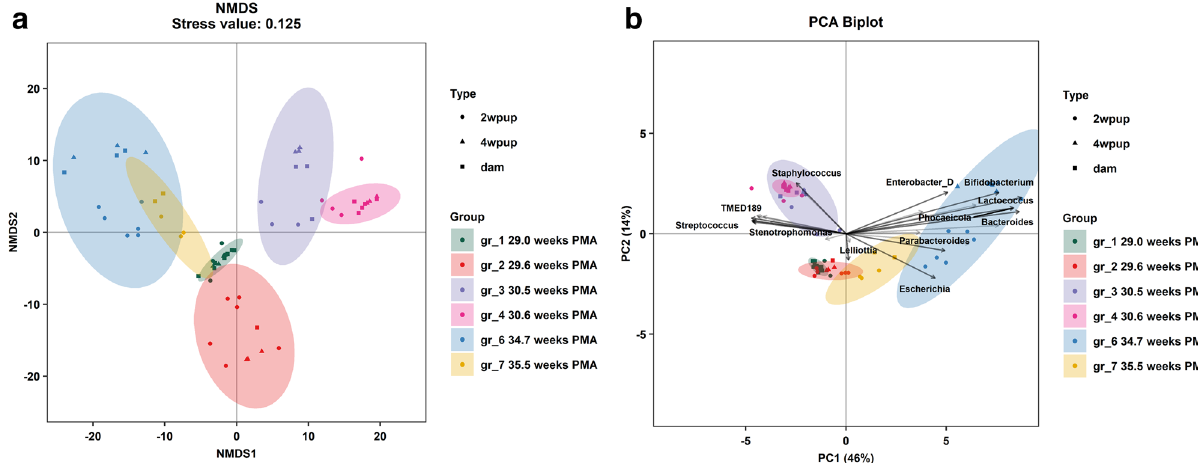
Figure 1. Microbial analysis of fecal samples from dam, 2 weeks old (2wpup) and 4 weeks old pups (4wpup). ( a ) Significant separation in the gut microbiome composition (beta-diversity) was observed among different transfaunation groups (gr) by PERMANOVA (color, p = 0.001) and no differences were detected among sample types (shape: 2wpup, 4wpup and dam) while controlling for group (PERMANOVA, p = 0.071). NMDS plot was generated using Aitchison distance metric at genus level. ( b ) Principal Component Analysis (PCA) biplot showed the variation among the fecal samples based on type and transfaunation groups and the relative abundance of microbial taxa (genera). Arrows represent the strength (through the length) of each taxa to the overall